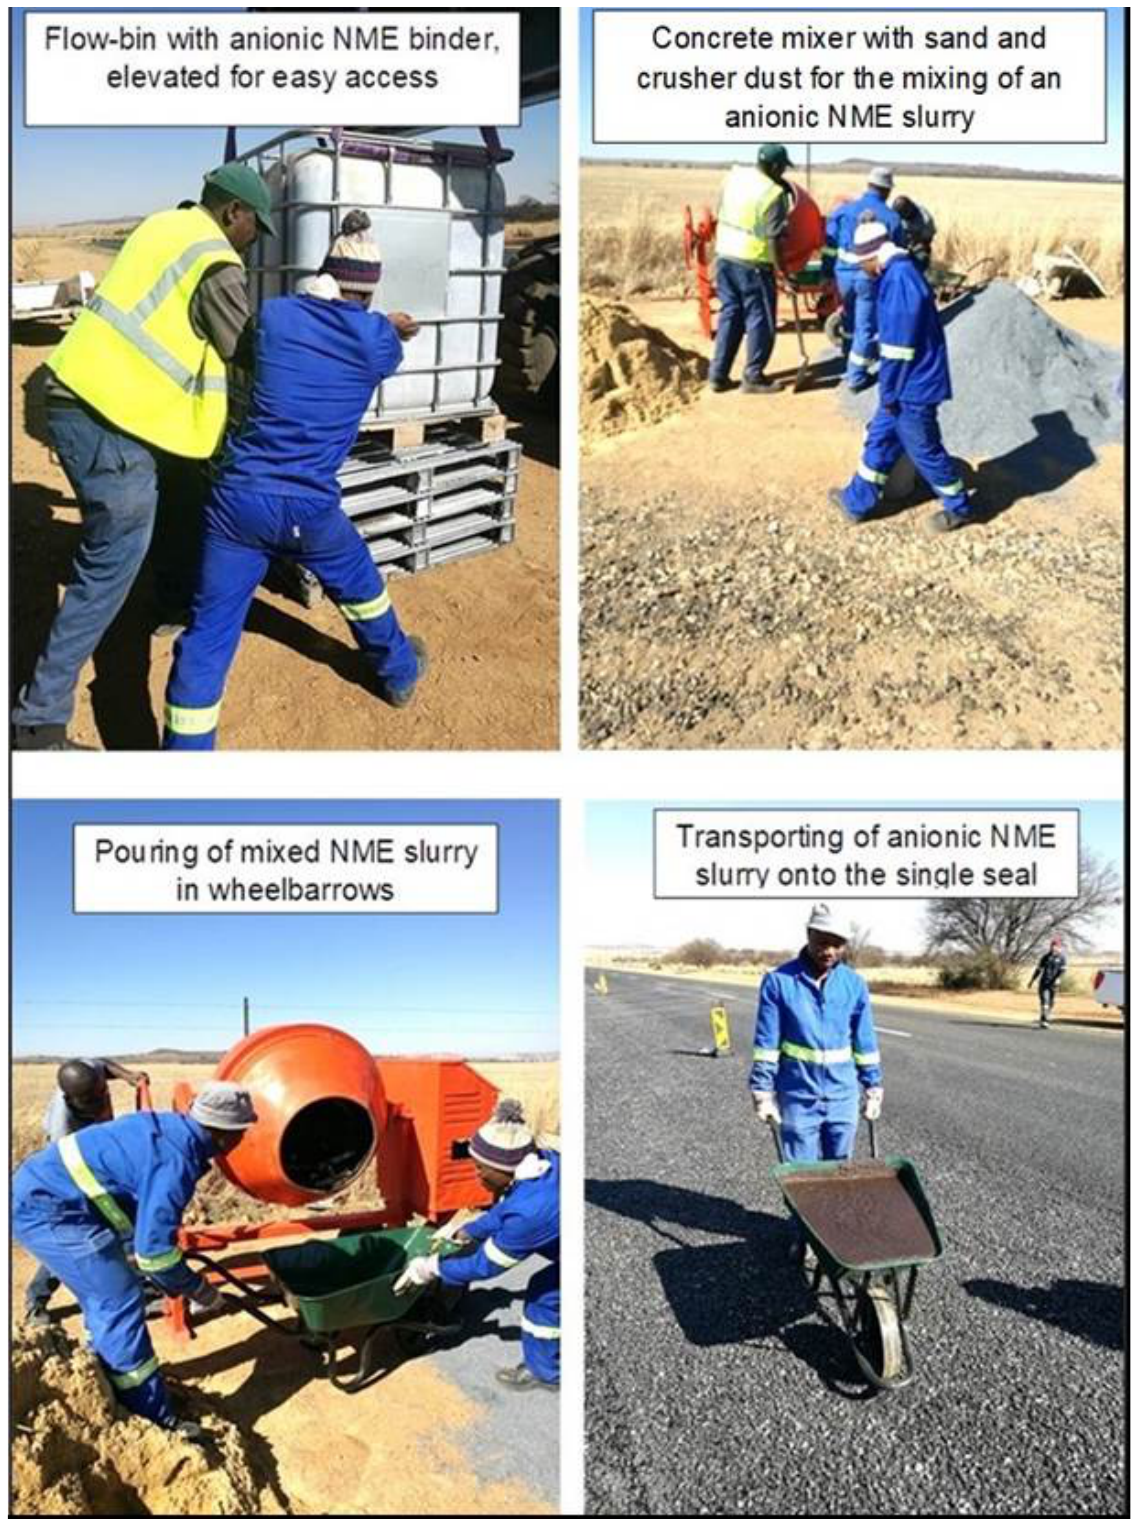
Figure 19. Labour-intensive road-side manufacturing of the slurry mix for a modified cape seal using an anionic NME binder.